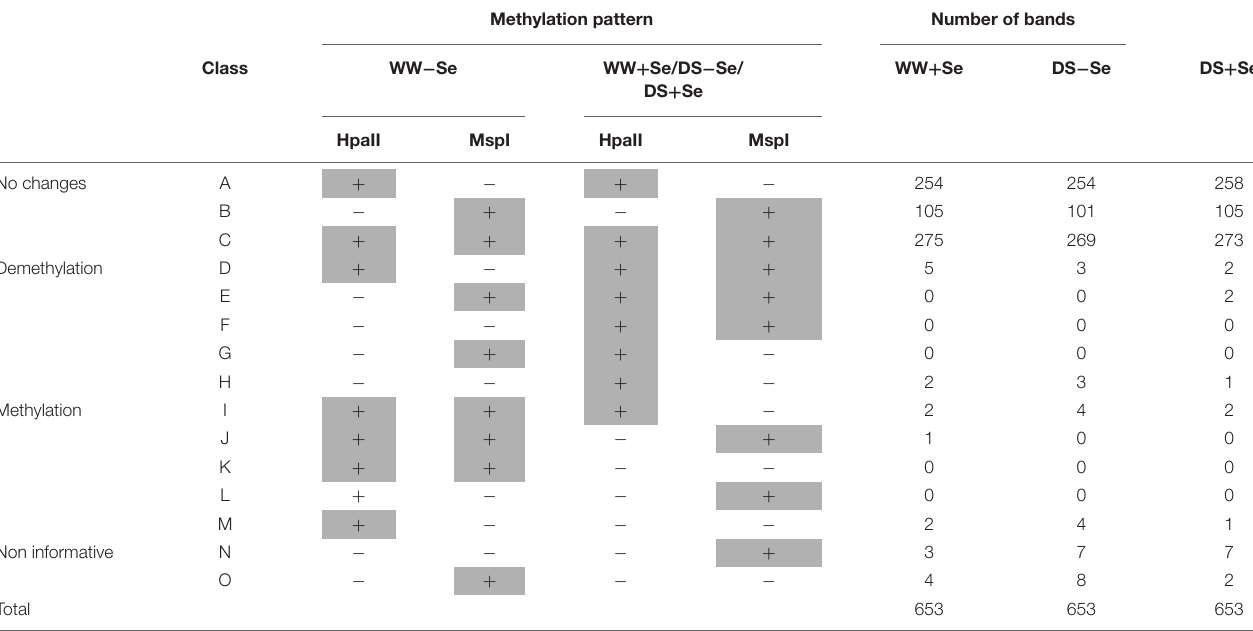
TABLE 4 | Variations in DNA methylation pattern of Z. mays in different grown conditions: normal irrigation without (WW − Se) or with (WW + Se) selenium treatment and drought stress without (DS − Se) or with (DS + Se) selenium treatment. Methylation